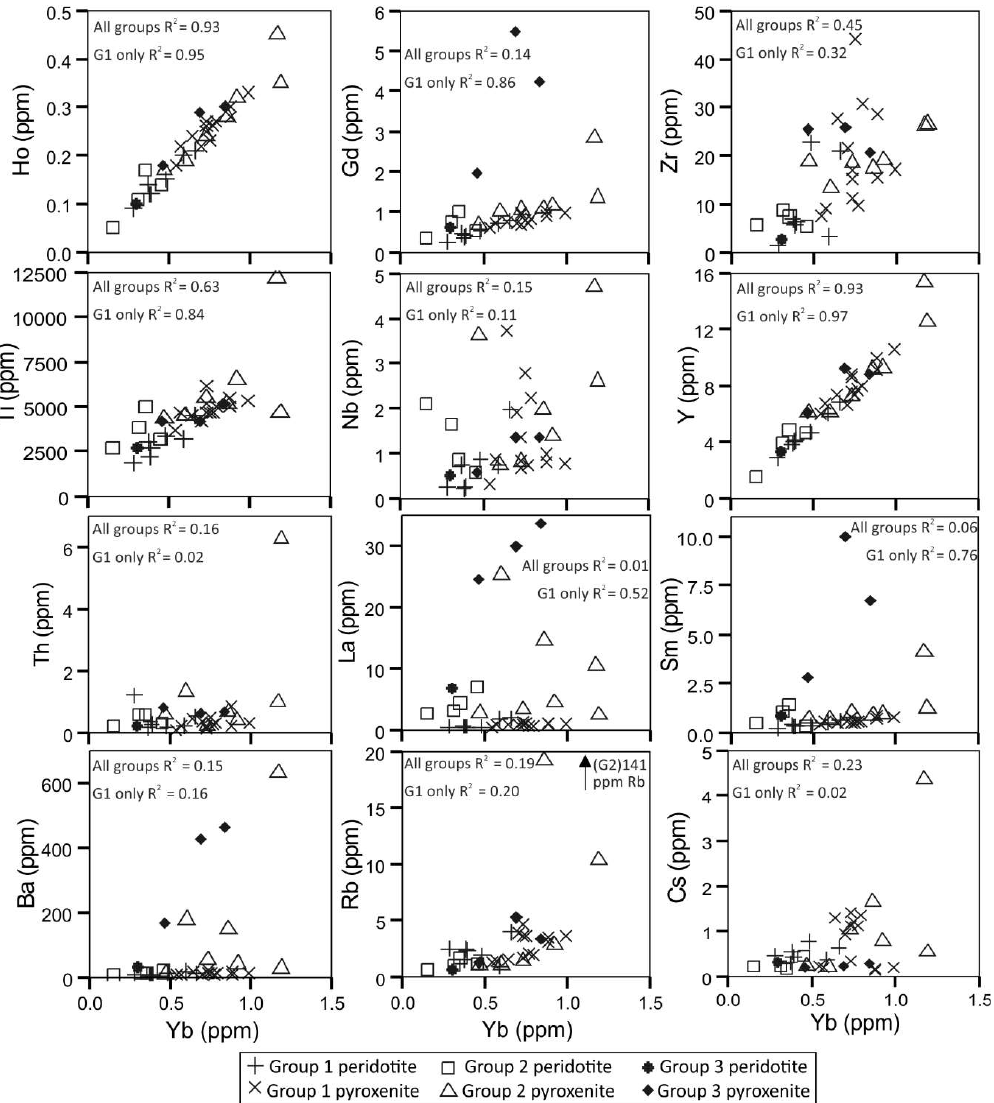
Figure 6. Bivariate plots detailing the trace-element compositions of the Ben Strome samples.